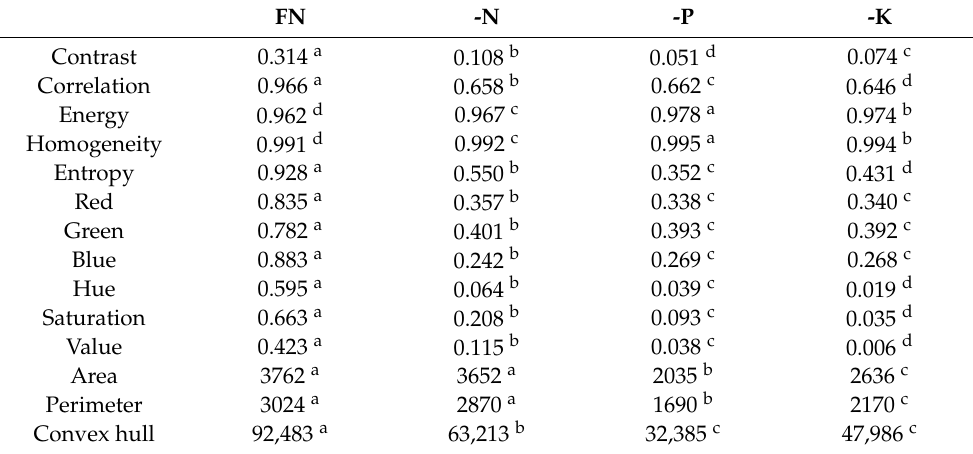
Table 6. Results of statistical analysis of variance (ANOVA) and orthogonal comparisons using Tukey’s HSD test